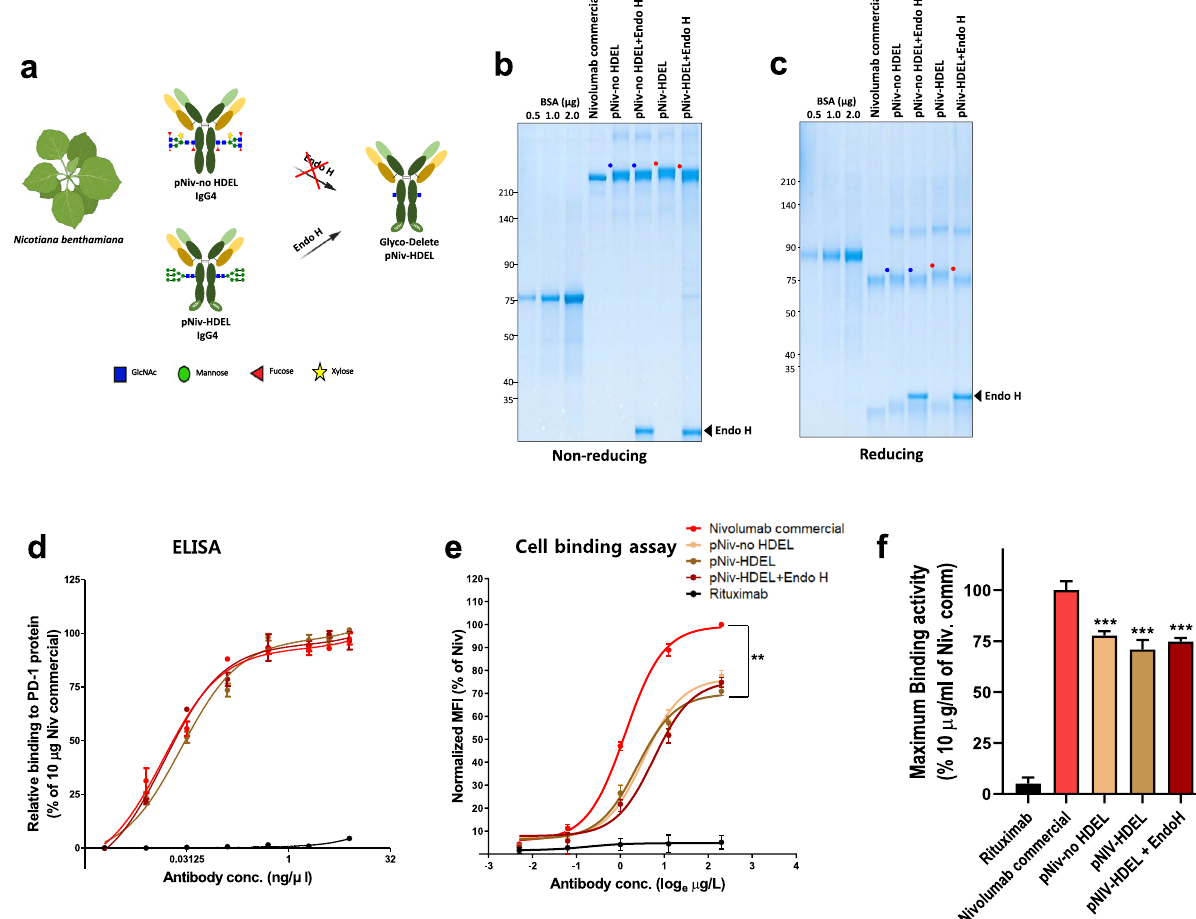
Figure 3. Production of plant GD nivolumab in Nicotiana benthamiana . ( a ) Schematic representation of plant nivolumab heavy chain and light chain produced in N. benthamian a leaves using the transient infiltration method. ( b ), ( c ) CHO-nivolumab, plant nivolumab no HDEL, plant-nivolumab-HDEL, and plant nivolumab with Endo H treatment were subjected to SDS-PAGE under non-reducing ( b ) and reducing ( c ) conditions. BSA (0.5 μg, 1.0 μg, and 2.0 μg) was used as the standard. ( d,e ) PD-1 binding affinity of antibodies (CHO-nivolumab, plant-nivolumab-HDEL, plant-nivolumab-HDEL with Endo H, and rituximab) were analyzed by two methods. ( d ) Binding to human PD-1 protein, as determined by ELISA. Two-fold dilutions of the antibodies were incubated on plates coated with the human PD-1 protein and detected with HRP-conjugated anti-human IgG antibody. ( e ) Cell surface PD-1 binding affinity was analyzed with PD-1–expressing CHO cells using FACS. Various concentrations (0.1 μg/mL, 0.3 μg/mL, 1 μg/mL, 3 μg/mL, and 10 μg/mL) of each antibody were used, with 2 nd anti-human IgG-FITC was used to detect each antibody. (f) The activity of each antibody at the maximum concentration (10 μg/ml) of each antibody was summarized. The mean fluorescence intensity (MFI) of FITC treated with nivolumab commercial (10 μg/mL) was normalized to 100%. The MFI of each antibody- treated cell was expressed as the relative %. ***p ≤ 0.001 compared to 10 μg/mL of nivolumab commercial. Rituximab was used as negative control in (d) and (e,f) Endo H activity was only shown in plant nivolumab-HDEL, not in nivolumab-no-HDEL, confirmed that plant GD-nivolumab was successfully produced via in vitro enzyme reaction of Endo H from plant nivolumab HDEL.